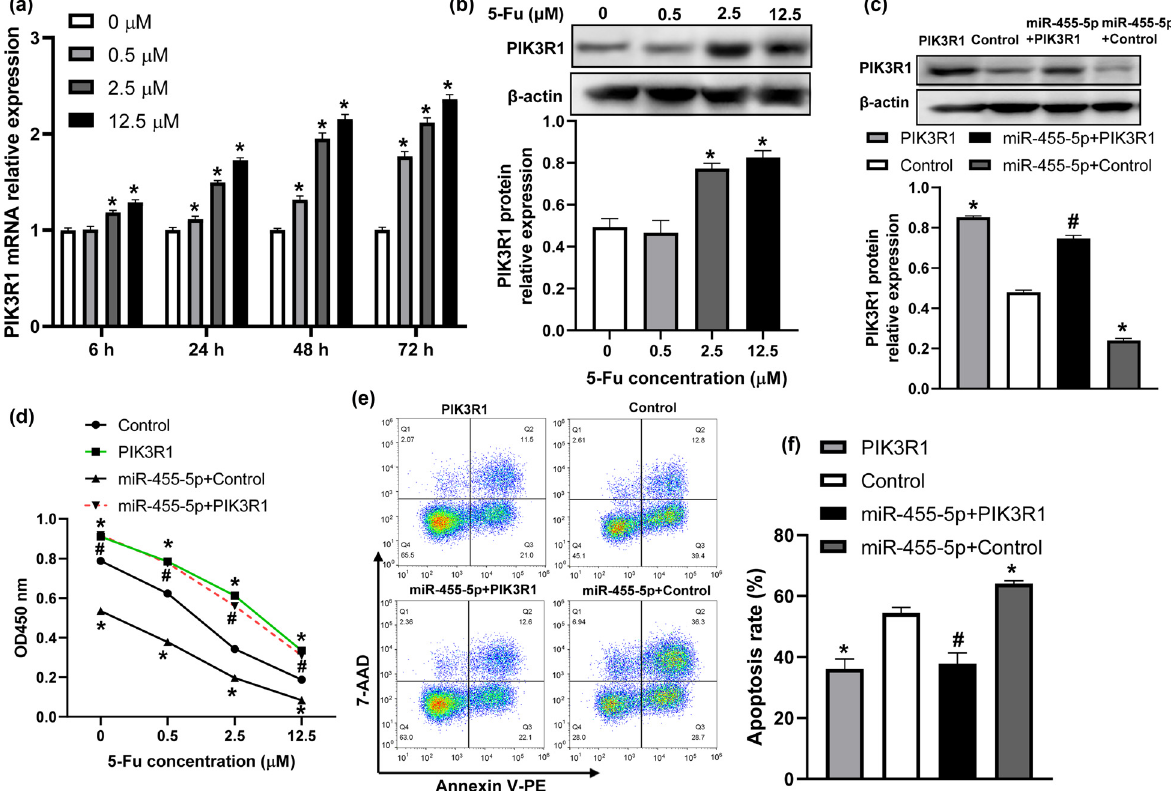
Figure 3: PIK3R1 was a target of miR - 455 - 5p in 5 - Fu - treated CRC cells. ( a ) PIK3R1 mRNA expression was detected in HT - 29 cells after treatment with di ff erent concentrations of 5 - Fu for 6, 24, 48, and 72h. ( b ) PIK3R1 protein level was analyzed in HT - 29 cells treated with 5 - Fu for 48h. ( c ) HT - 29 cells were transfected with PIK3R1 overexpressing plasmid or pcDNA3.1 control plasmid, or co - transfected with miR - 455 - 5p mimic and PIK3R1 overexpressing plasmid or pcDNA3.1 control plasmid for 24h, and then exposed to 2.5 μ M 5 - Fu for 48h. PIK3R1 protein level was measured by western blot. ( d ) Cell viability was determined by CCK - 8. ( e and f ) Flow cytometry was used to assay the apoptosis of HT - 29 cells under di ff erent treatments. * P < 0.05 vs the control group, # P < 0.05 vs the miR - 455 - 5p + control